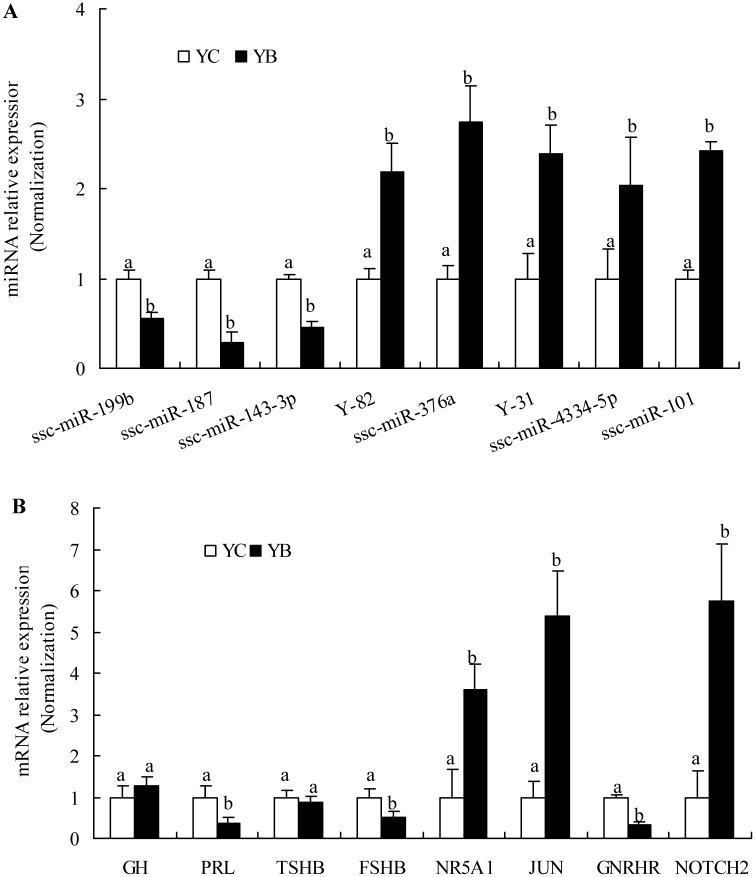
qRT–PCR validations of miRNAs and mRNAs (transcripts).(A) Eight differentially expressed miRNAs. (B) Five differentially expressed and three important transcripts in the pituitary. Data in columns are means ± SD. The expression abundance of Landrace (YC) was normalized to 1. Statistical significance was determined by Student's t test, p<0.05 was considered significant.; the panels with different letters were considered statistically significant (p < 0.05).